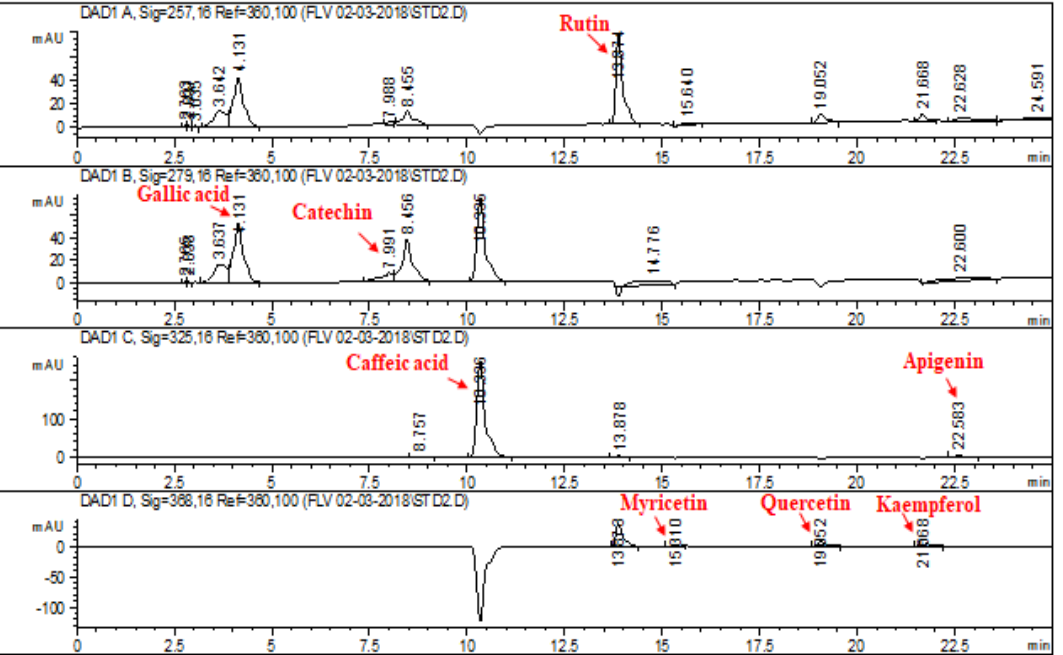
Figure 1. HPLC–DAD profile of reference standards for crude extracts and derived fractions of L. corymbulosum (LCM, LCE, LCB and LCA) at varying wavelengths. Signal 1: 257 λ , signal 2: 279 λ , signal 3: 325 λ , signal 4; 368 λ . Conditions: Mobile-phase A—ACN:MEOH:H 2 O:AA, 5:10:85:1; mobile- phase B–ACN:MEOH:AA, 40:60:1; injection volume 20 µ L; flow rate 1 mL/min; Agilent